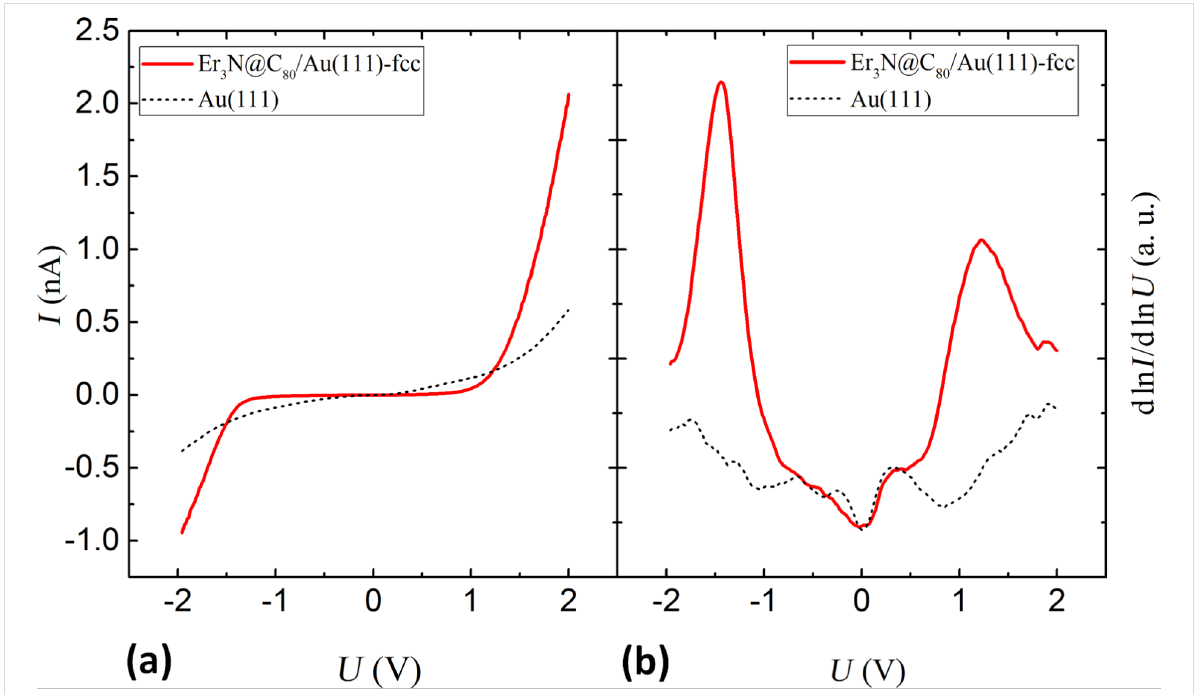
Figure 4: The I / U -spectrum (a) and the normalized dln I /dln U -spectrum (b) of Er 3 N@C 80 /Au(111). The voltage is considered as applied to the sample. The Au(111) surface state is not visible in the spectrum.